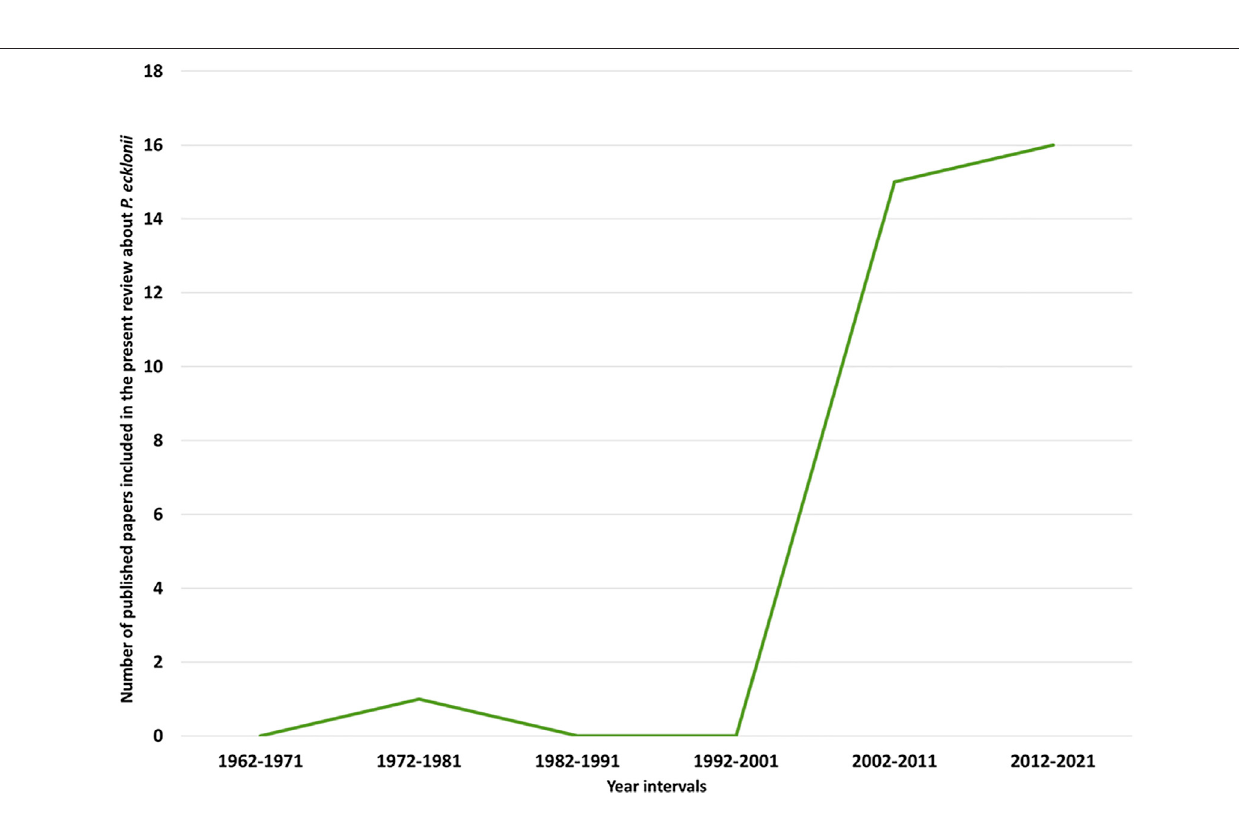
FIGURE 2 | Number of published papers on P. ecklonii included in this